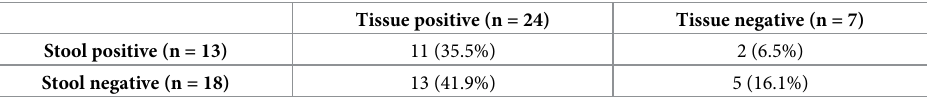
Table 3. Stool test results compared to tissue biopsy results in patients who underwent both stool testing for mycobacteria and evaluation of tissue biopsies obtained during colonoscopy to diagnose intestinal tuberculosis (N =